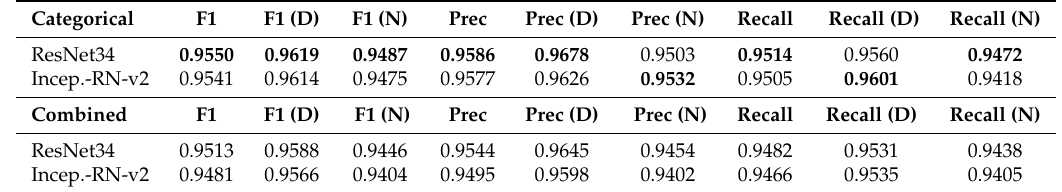
Table 8. Detailed listing of F1 score, precision, and recall: The experiment was carried out on all test images and separately on the daylight (D) and night vision (N) images only.